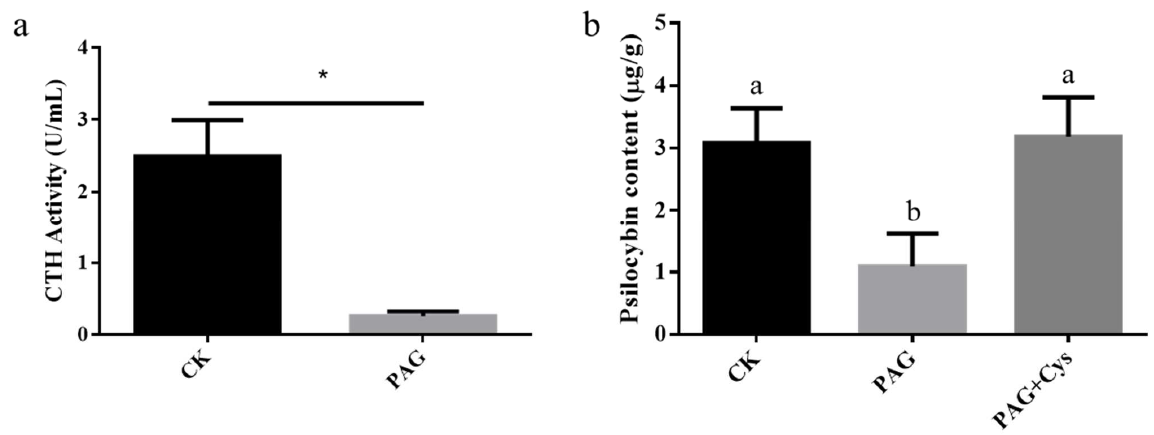
Figure 10. The impact of PAG and L-cysteine on psilocybin biosynthesis. (( a ): The impact of PAG on CTH activity; ( b ): The impact of PAG on psilocybin content. Paired t -test, * indicated p < 0.05; different letters indicated significant differences).